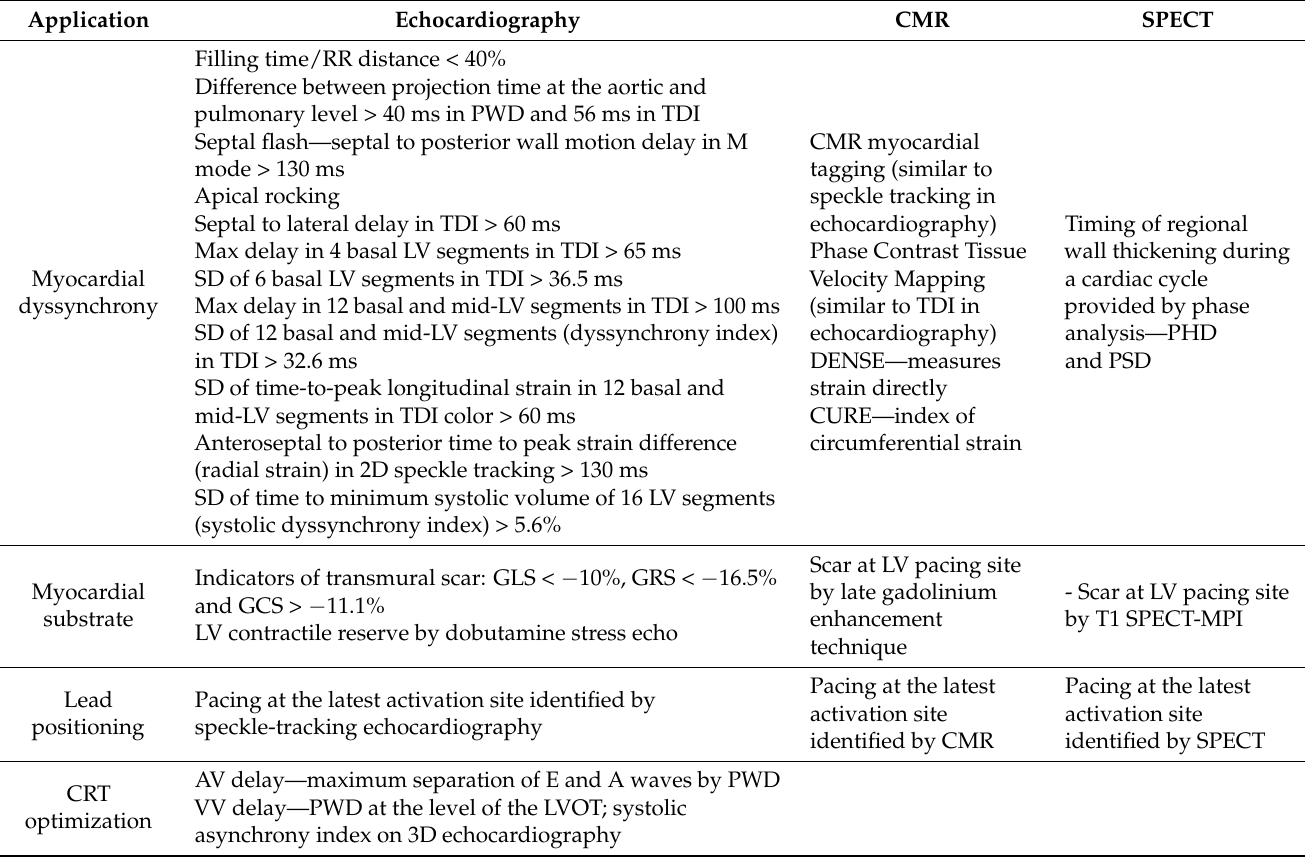
Table 2. Multimodality imaging for improving CRT response—validated